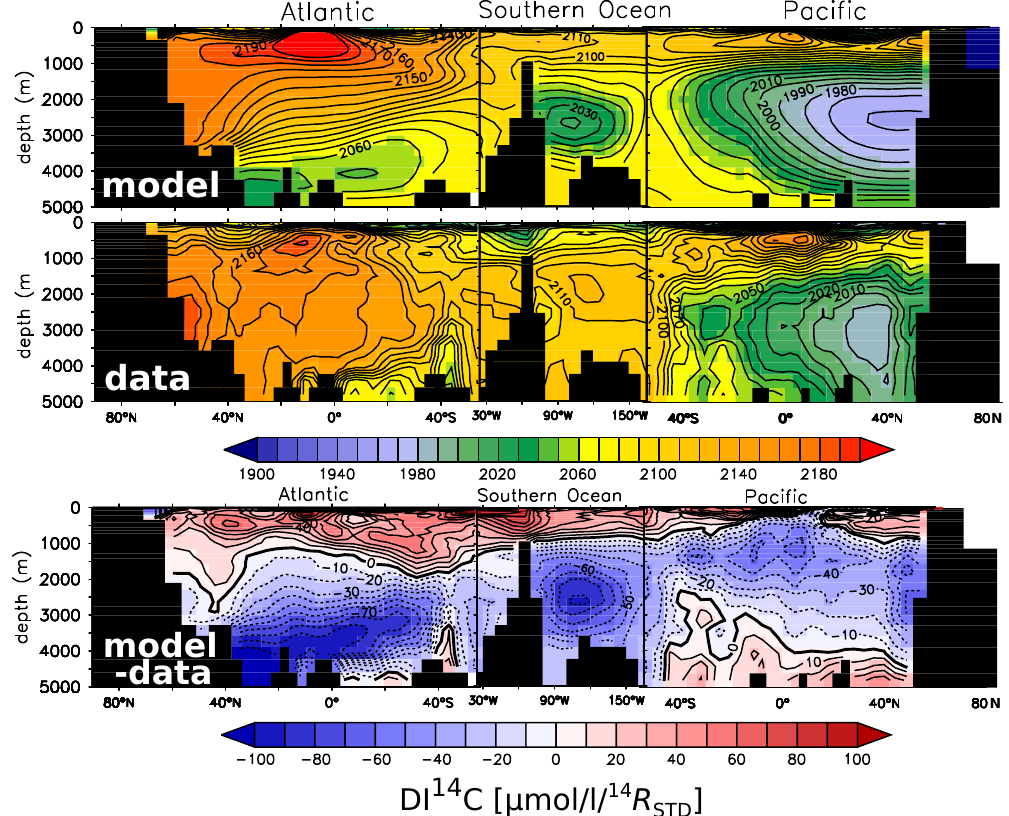
Fig. 7. Comparison of modern modelled and data-based (GLODAP,WOA09) oceanic distribution of 14 C in its dominant form of dissolved in- organic carbon (DI 14 C) along a transect through the Atlantic, Southern Ocean and Pacific. The lowest panel shows the model–data difference.